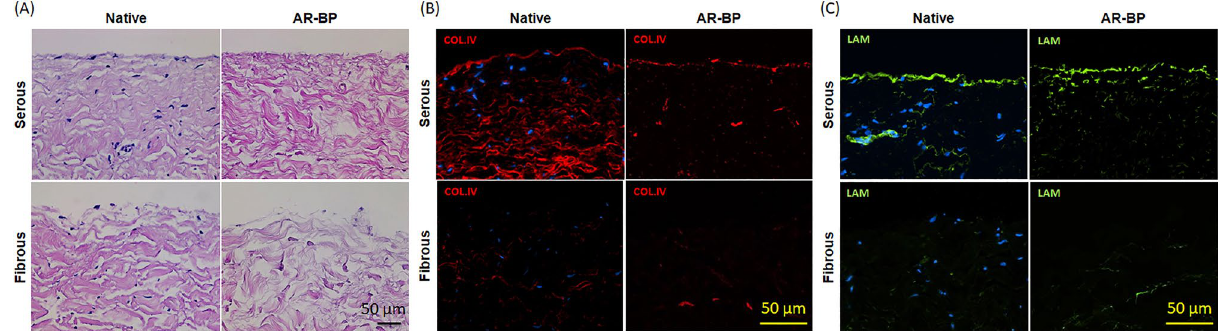
Figure 1. Hematoxylin & eosin (HE) and basement membrane proteins staining of serous and fibrous surface of native BP and AR-BP. ( A ) HE staining demonstrating that AR scaffolds are completely acellular, while retaining native BP collagen organization. ( B ) Collagen IV immunofluoresence staining demonstrating that AR-BP scaffolds retain native Col IV staining on the serous surface and vascular lumen. Fibrous surface of both native and AR-BP scaffolds does not contain Col IV. ( C ) Laminin immunofluoresence staining demonstrating retention of native tissue laminin content and organization, on the serous surface and vascular lumen of AR-BP